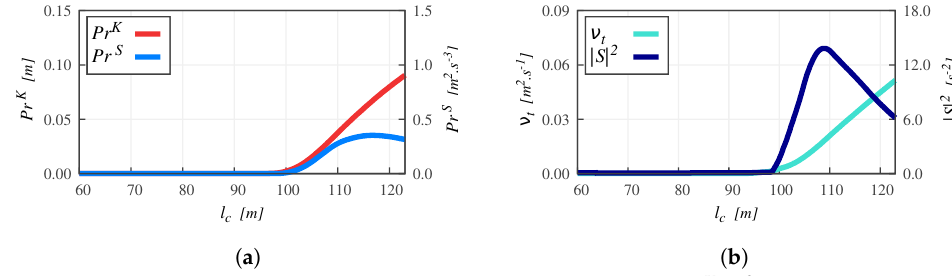
OpenFOAM 2D spillway water surface fi elds: Figure 9. Spillway chute—profiles at l c = { 60, 100, 120 } m: ( a ) V . ( b ) ν t . ( c ) | S | 2 . ( d ) P S r . ( e ) k .